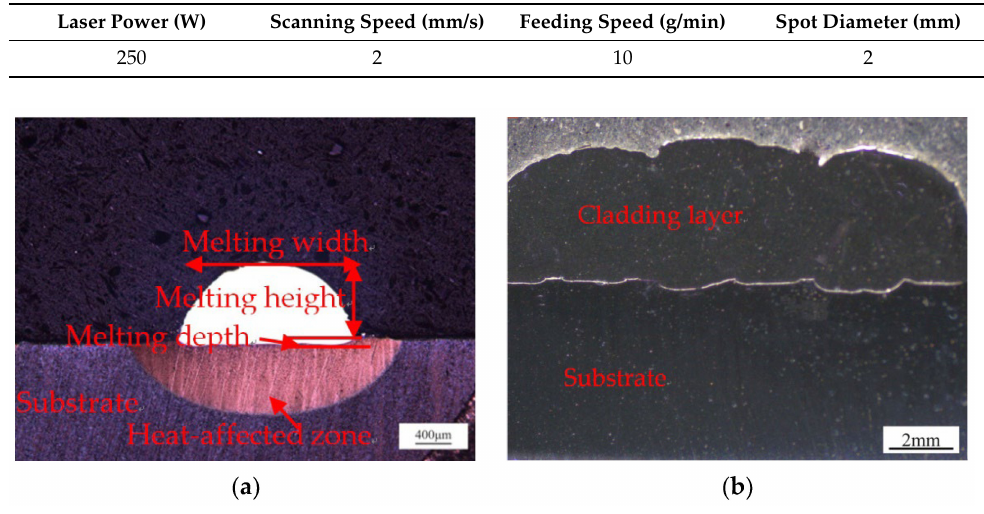
Figure 3. Macroscopic morphology observation of the cross-section of the cladding layer: ( a ) the optimal process parameters and ( b ) the overlap rate of